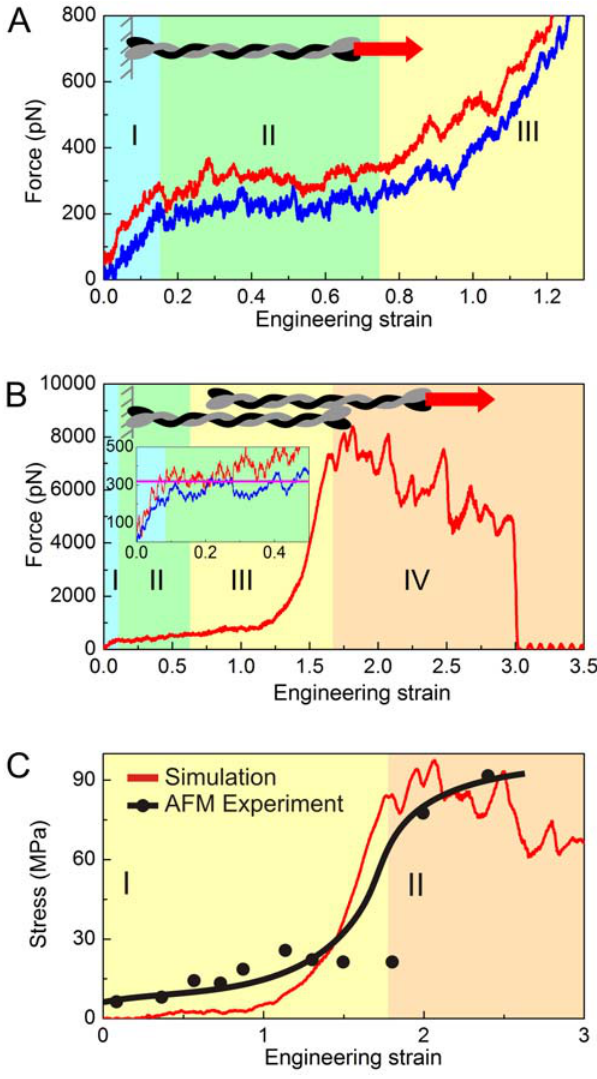
Figure 4. Force-strain relations for tensile deformation of the vimentin dimer, tetramer, as well as stress-strain relationship of full-length filaments (including comparison with AFM nanomechanics experiments). Panel A: Force-strain curve of the dimer (0.01 A˚/ps and 0.1 A˚/ps pulling speeds). The force-strain curve features three regimes: (I), The force increases linearly with strain until the rupture of the H-bonds and uncoiling of alpha-helices sets in. (II), A plateau of a constant force is found during which the unfolding process takes place. (III), The filament stiffens significantly due to stretching of the protein backbone. Panel B: Force-strain curve of the tetramer (0.1 A˚/ ps pulling speed; results for 0.01 A˚/ps pulling speed are shown in the inlay for strains less than 50%). The pink bar in the inlay denotes the unfolding force for a dimer. The force-strain curve features four regimes: (I), The force increases linearly with strain until the rupture of the H- bonds and uncoiling of alpha-helices begins. (II), Plateau with approximately constant force, where the unfolding of 2B segment takes place. (III), Unfolding of the 1A, 1B and 2B segments. (IV), Interdimer sliding. Panel C: Stress-strain behavior of IFs, quantitative comparison between simulation and experiment. The black curve depicts experimental results of stretching single IFs (data taken from reference [8]). The two regimes (I) and (II) indicated by different shades refer to unfolding of alpha-helices and interdimer sliding between dimers beyond 175% strain, respectively.